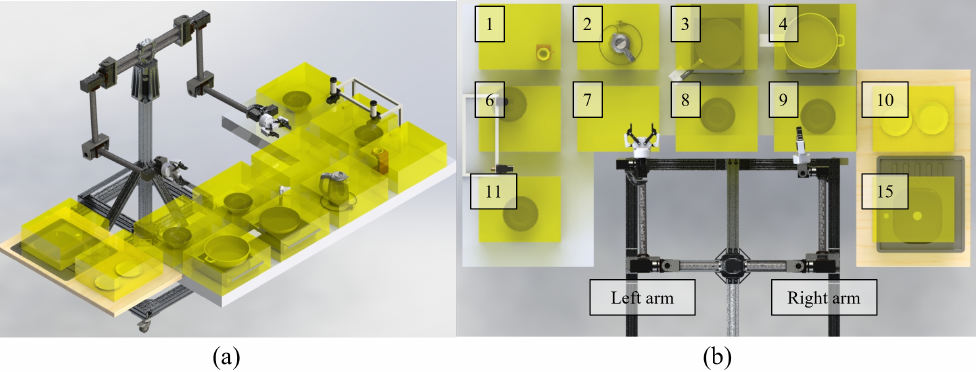
Figure 2. The environment of the cooking robot. ( a ) Isometric view of the whole environment. Yellow cubes represent pre-defined locations for defining tasks. ( b ) Top view of the environment. The meaning of number in white box is the index of